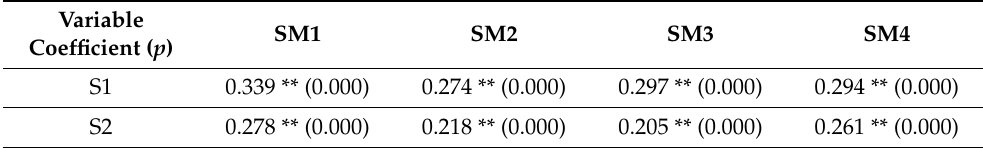
Table 5. Sustainability vs. Smart Mobility—Pearson correlation results.